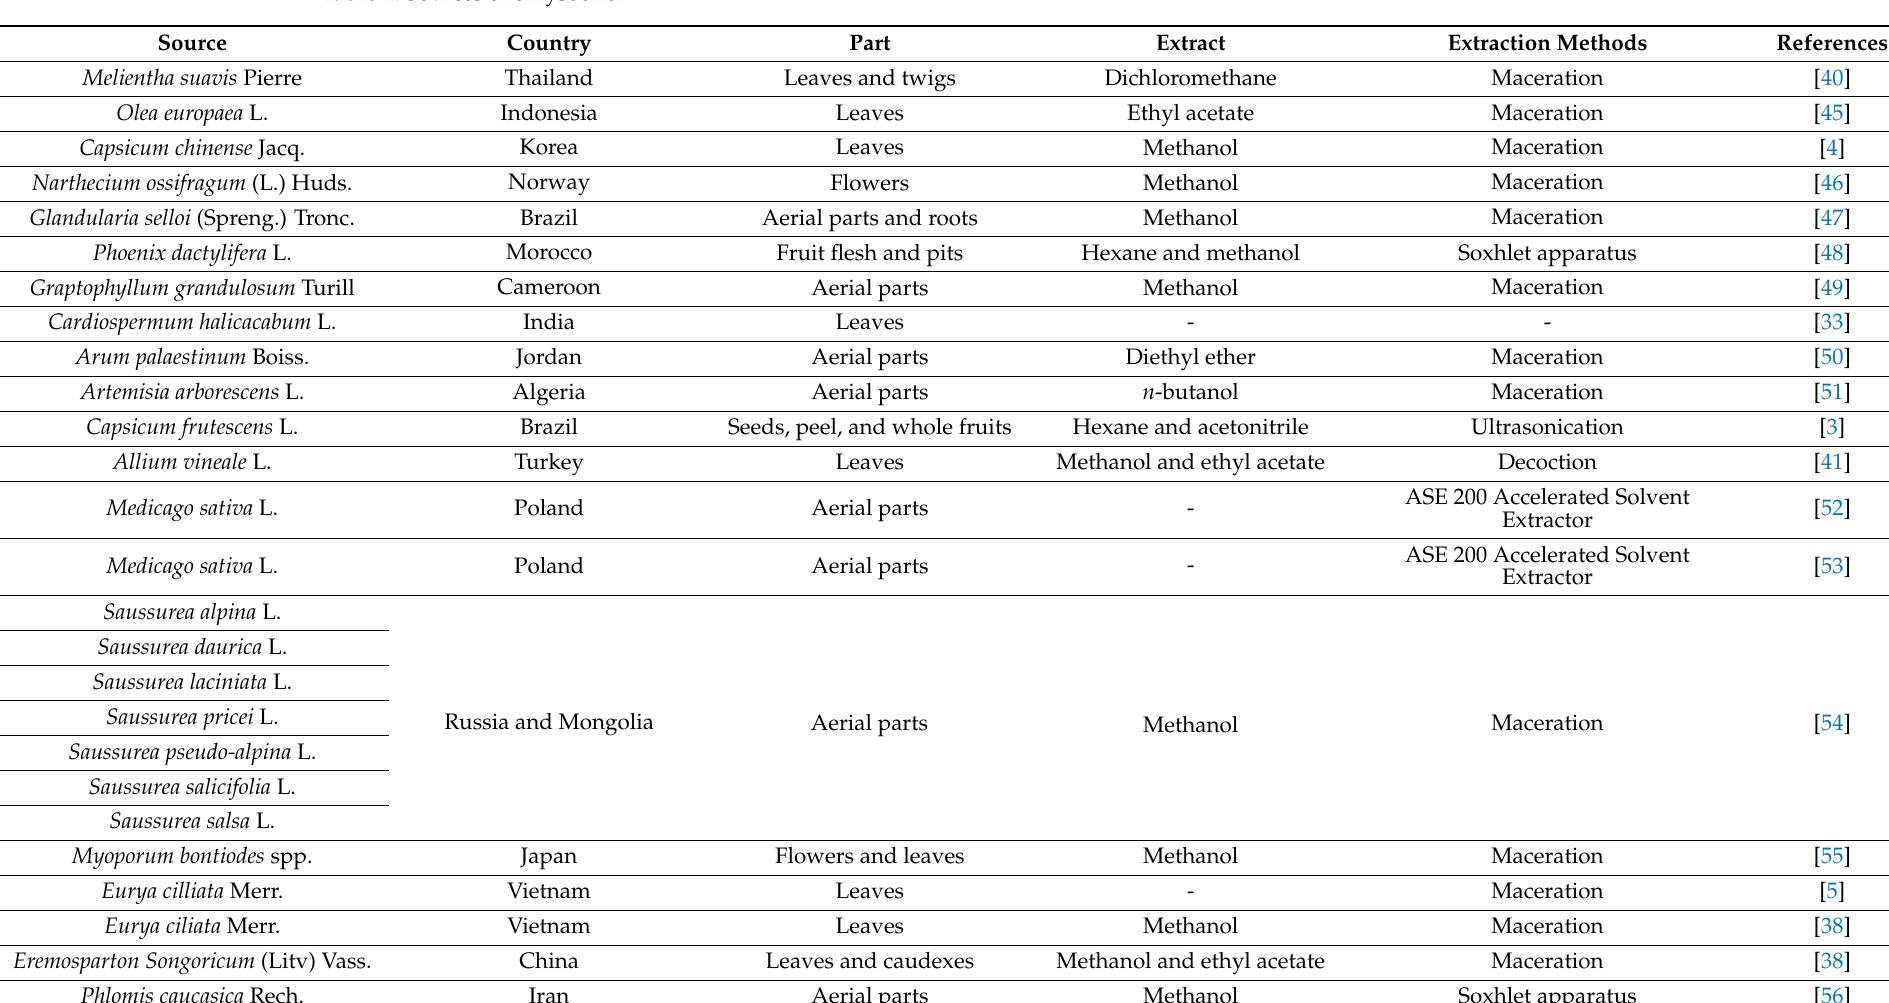
Table 1. Sources of